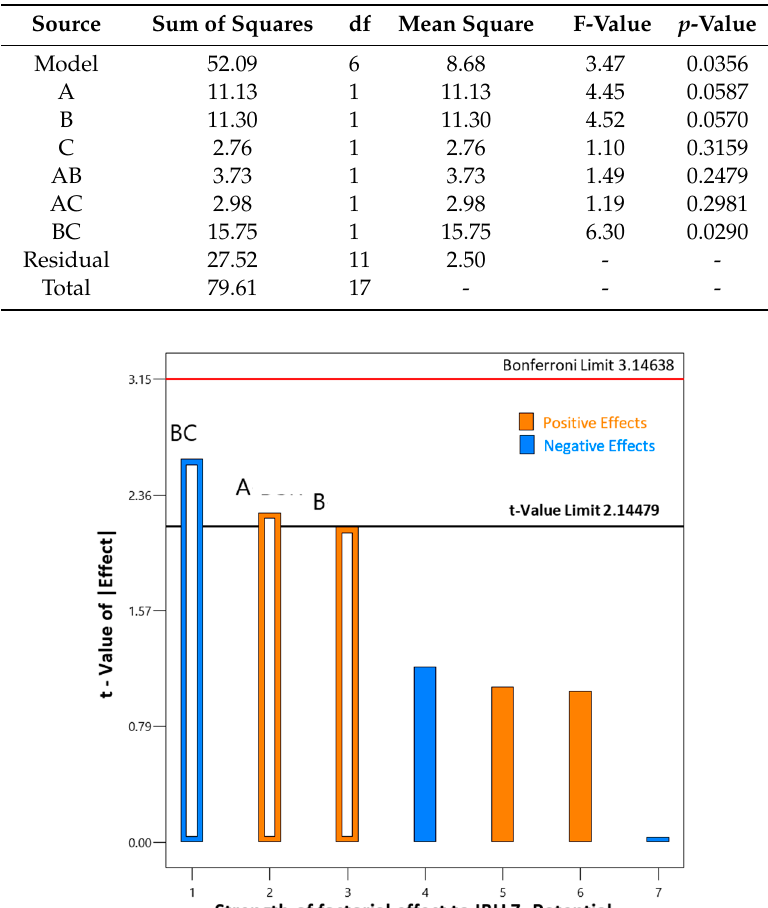
Figure 5. Concave frequency of occurrence of factor main and/or interaction effect versus the cumulative percentage of the total number of occurrences; the two factor interaction BC, and main effects of factors A and B are deemed significant.